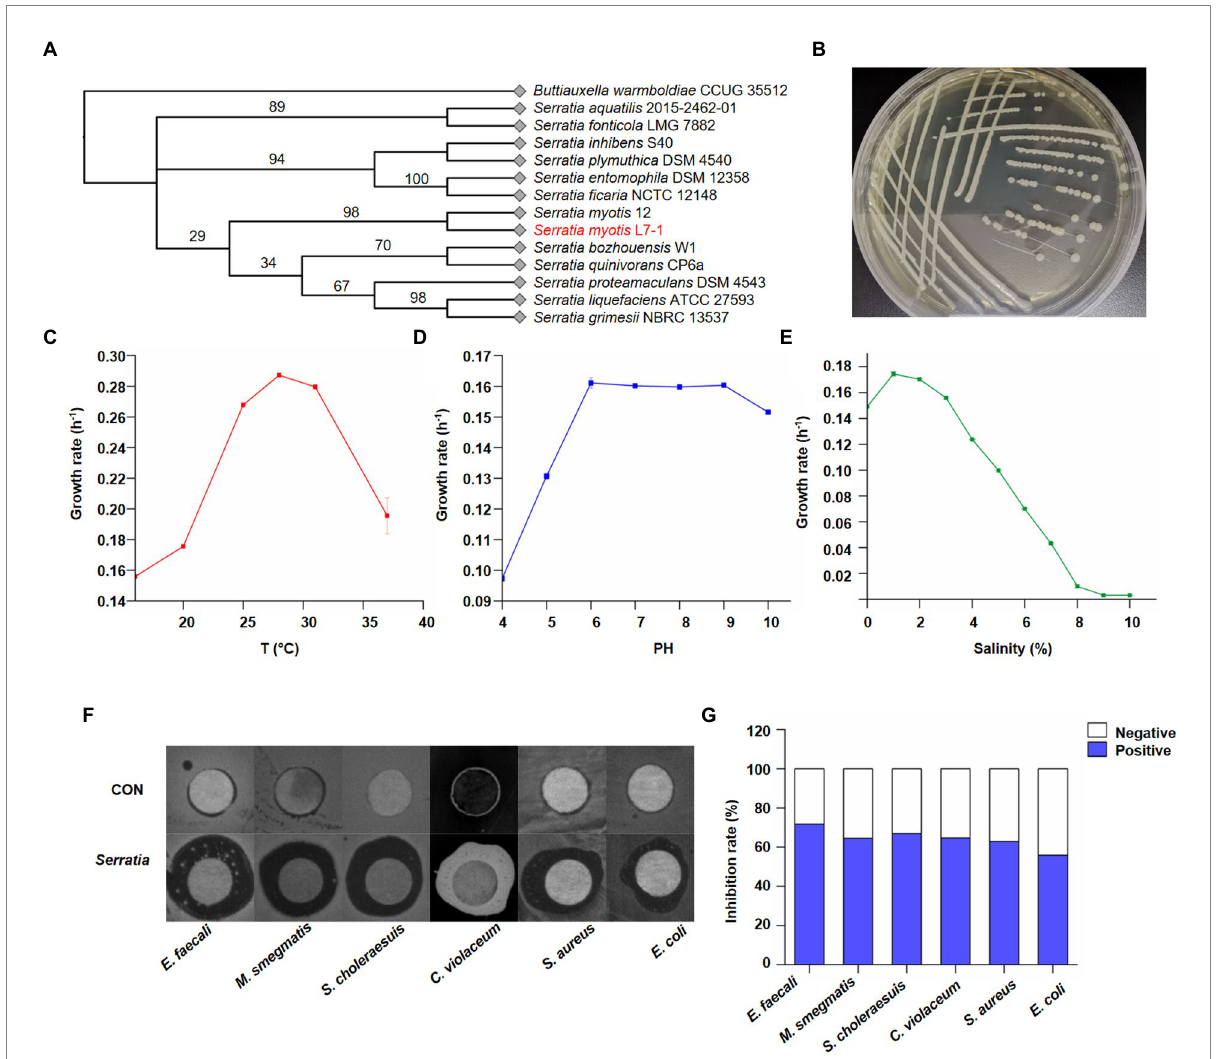
FIGURE 2 Identification of Serratia myoti s as the core symbiotic bacteria. (A) Neighbor-joining tree based on nearly complete 16S rDNA gene sequences of Serratia myotis L7-1 and close taxa of the genus Serratia . Buttiauxella warmboldiae CCUG 35512 was used as an outgroup. Itol.embl.de. (B) Macroscopic images showed the morphology of S. myotis L7-1 colony. (C) Growth rate of S. myotis L7-1 in different temperature ( n = 3). (D) Growth rate of S. myotis L7-1 in different PH values ( n = 3). (E) Growth rate of S. myotis L7-1 in different salinity ( n = 3). Origin 2022. (F) Zones of inhibition of the metabolites produced by Serratia . (G) In-vitro antimicrobial activity of the metabolites produced of the indicated Serratia strain. Origin